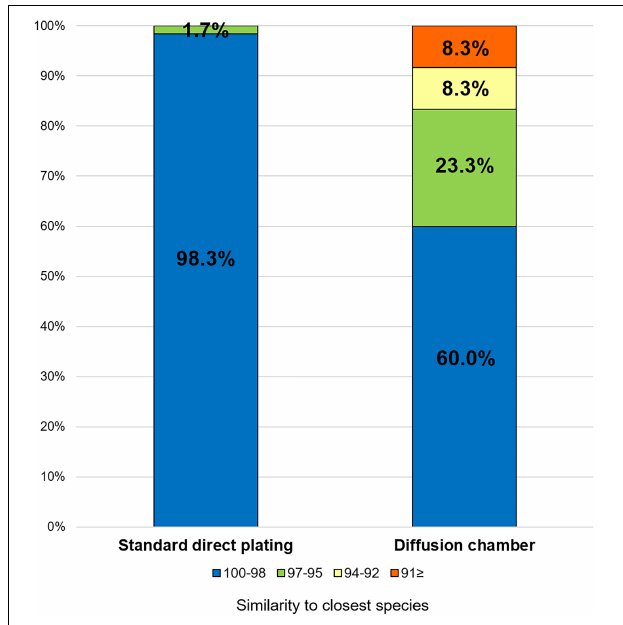
FIGURE 3 | Similarity among the isolates from each cultivation method based on the 16S rRNA gene to the closest known relative in GenBank. Numbers in the bar graphs represent ratio (%) for each similarity level.